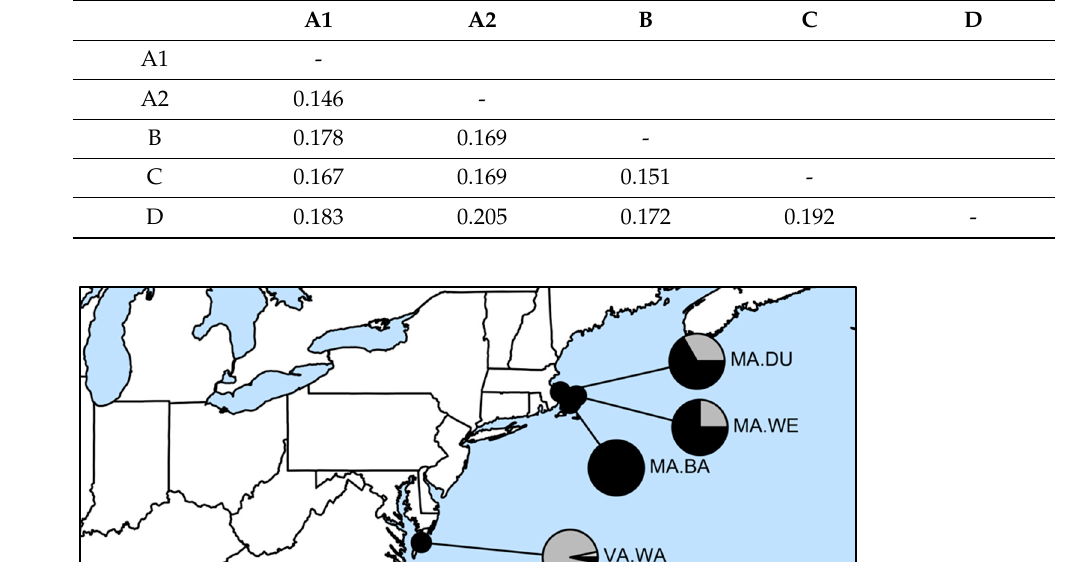
Table 3. Mean percent difference between COI haplotype clades.